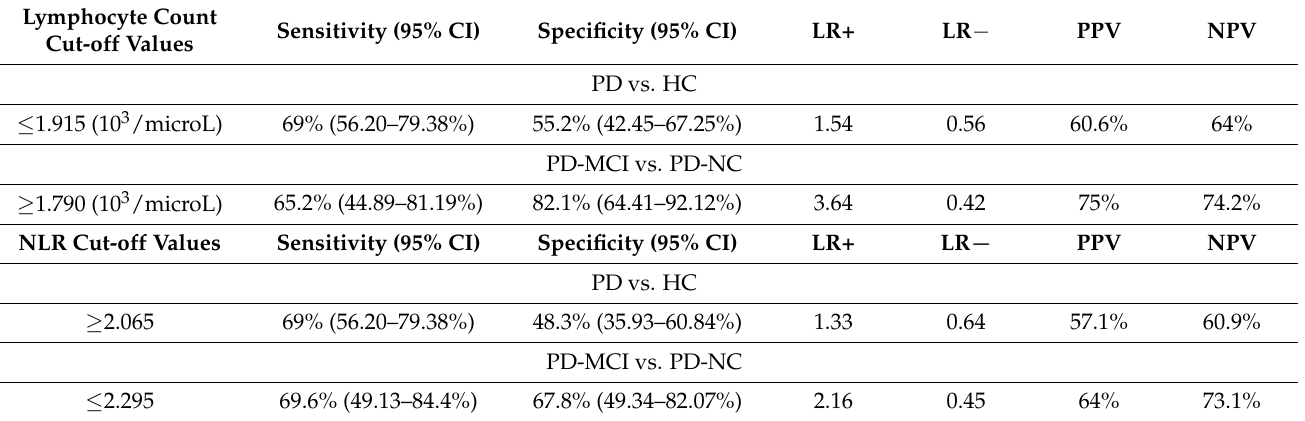
Table 2. Cut-offs of lymphocyte count and NLR to discriminate between PD vs. HC and PD-NC vs. PD-MCI, with sensitivity, specificity, positive and negative likelihood ratios, and positive and negative predictive values.